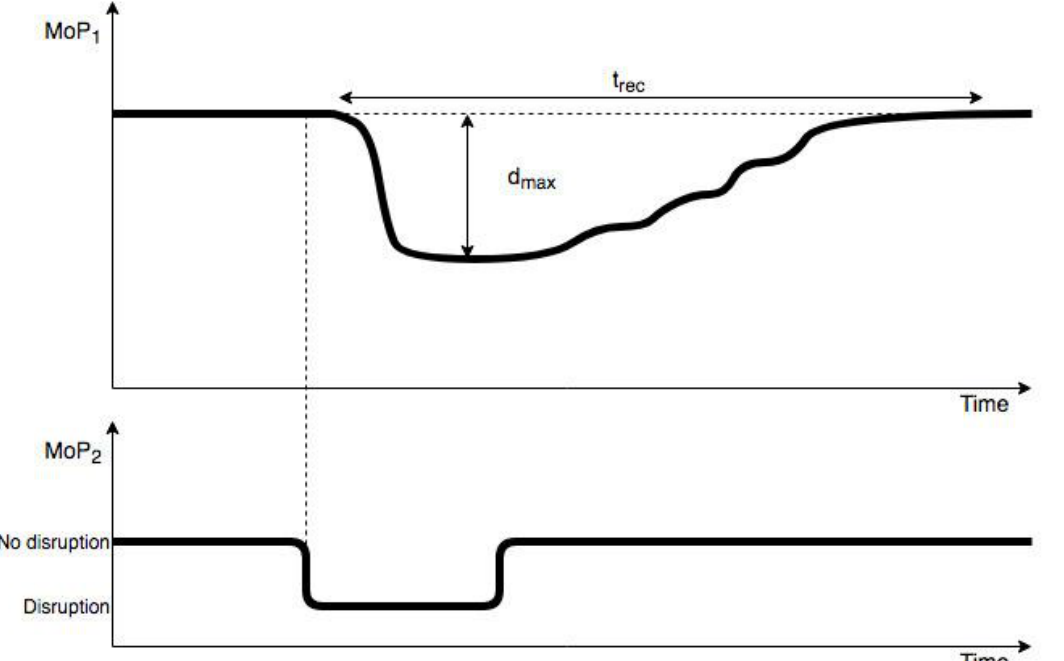
Figure 5. Recovery time (t rec ) and maximum disruption size (d max ) definitions. Disruption was introduced into water supply network (MoP 2 ) and propagated to business network (MoP 1 ).